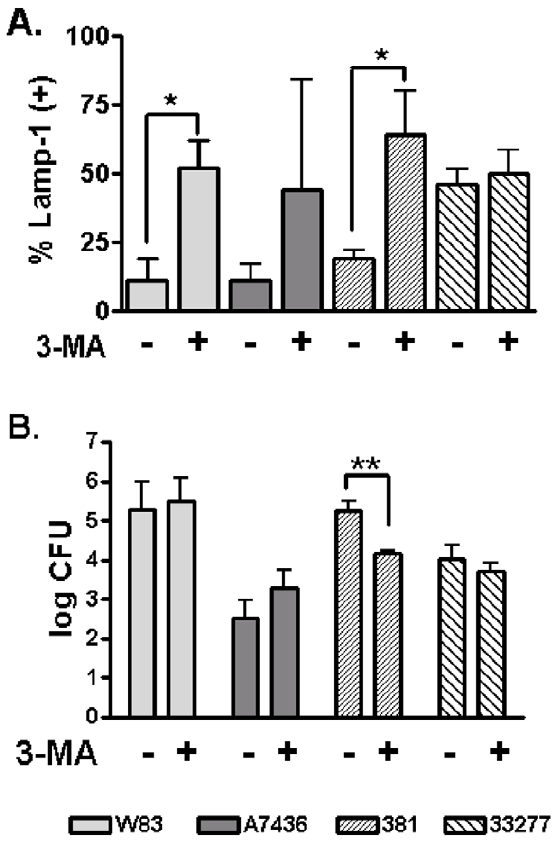
Figure 6. Impact of 3-MA treatment on the intracellular trafficking and survival of P.gingivalis . A) Mean percent 6 SD of internalized bacteria found in LAMP-1 positive vacuoles obtained from 3 biological replicates from 3 independent experiments. *Values were significantly different ( P , 0.05). B) Mean log CFU 6 SD (n=5) of internalized P. gingivalis recovered from HCAE cell lysates at 6 h post- inoculation. ** Values were significantly different ( P , 0.02).